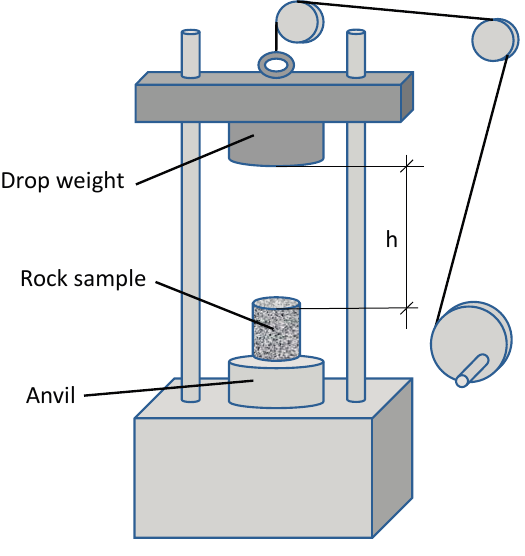
Figure 5. Drop weight